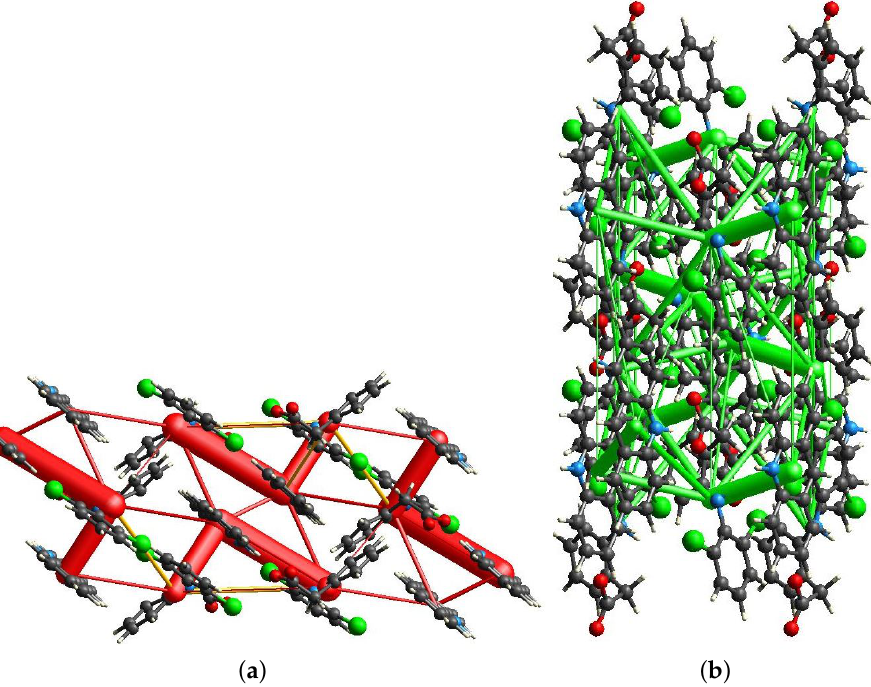
Figure 8. Energy frameworks calculated for salt form of the 1:1 LAG crystal structure. ( a ) Coulomb energy framework along the b-axis. ( b ) Dispersive energy framework along the